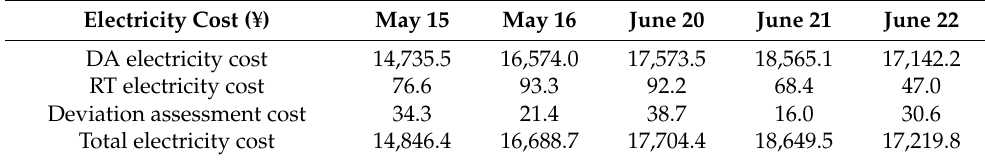
Table 4. Electricity costs of original load